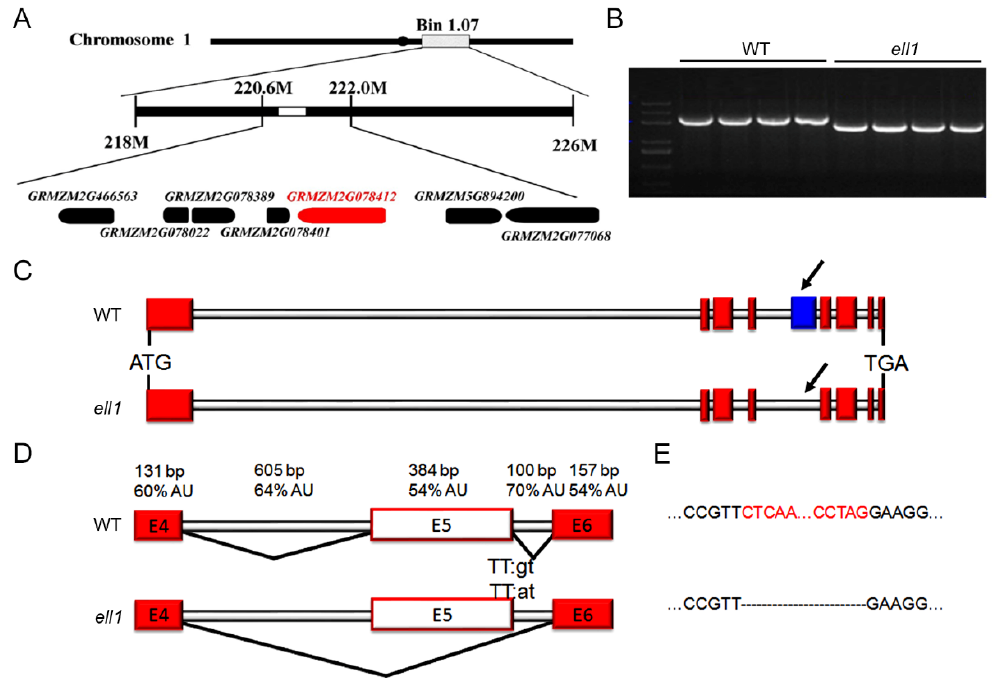
Figure 4. Positional cloning of the ZmCRS1 gene. ( A ) Fine mapping of the ZmELL1 gene and annotated genes in the 1.4 Mb region. ( B ) Amplification of GRMZM2G078412 in WT plant and ell1 mutant by PCR, cDNAs were used as templates. ( C ) Gene structure of ZmCRS1 in the wild-type and ell1 mutant. Exons are shown as red boxes and lines indicate the intron. The missing exon 5 is indicated as a blue box and black arrows. ( D ) Exon skipping of the ZmCRS1 gene. Splicing was analyzed between exon 4 (E4) and exon 6 (E6), the skipped exon 5 (E5) is shown as a white box. Percentage AU content of the exons (boxes) and introns (gray horizontal line), sizes are indicated in base pairs (bp). ( E ) Exon skipping of exon 5. Red letters indicate the missing cDNA region (corresponding to exon 5) which is represented as black dotted lines in ell1 . The sequence of the 5′ splice consensus site in the mutant is also shown. The thick black lines indicate the major splicing events in the WT and the ell1 mutant.